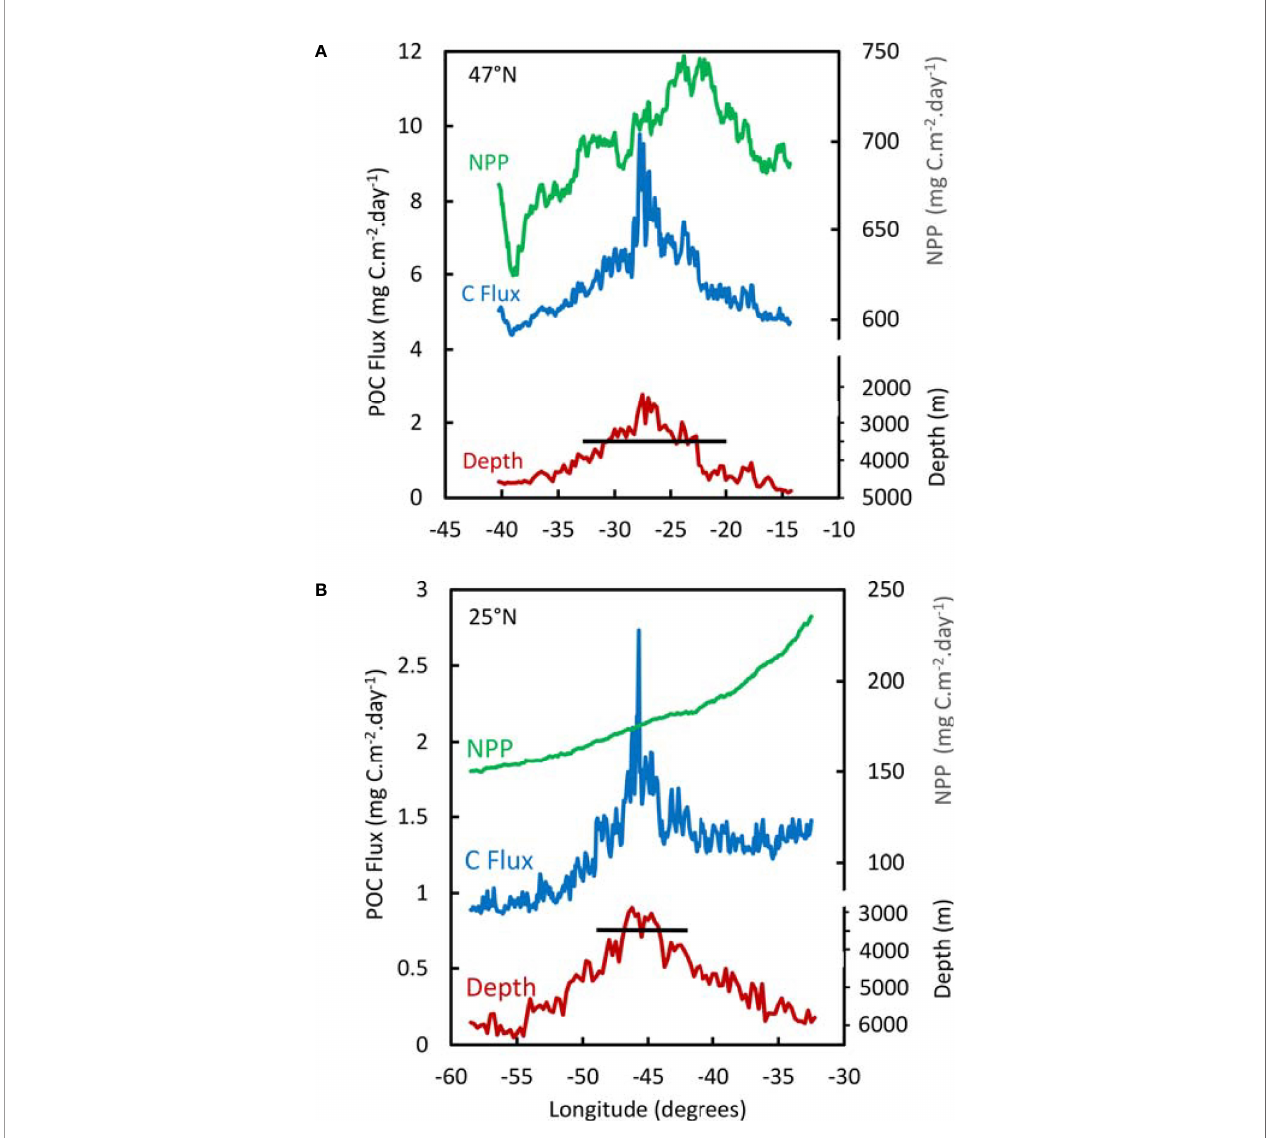
FIGURE 4 | Mean NPP and POC Flux during the years 2002-2020 along transects across the MAR at 47°N (A) and 25°N (B) . The horizontal black line indicates 3500 m depth, the boundary of the lower bathyal